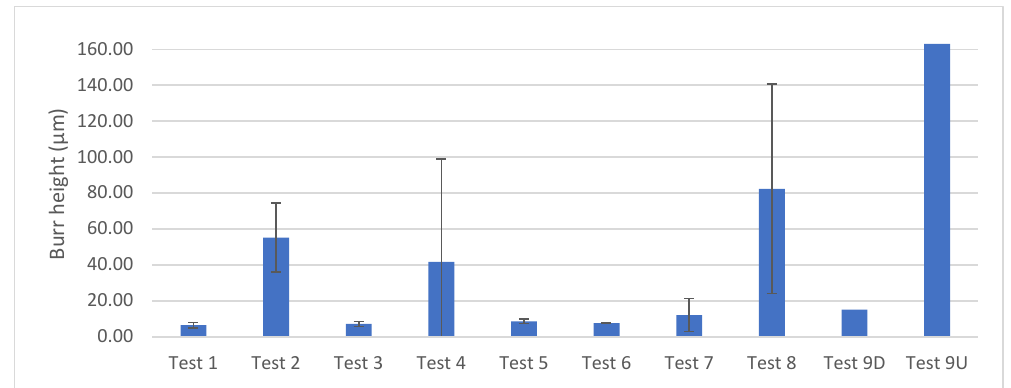
Figure 14. Measured burr height values.